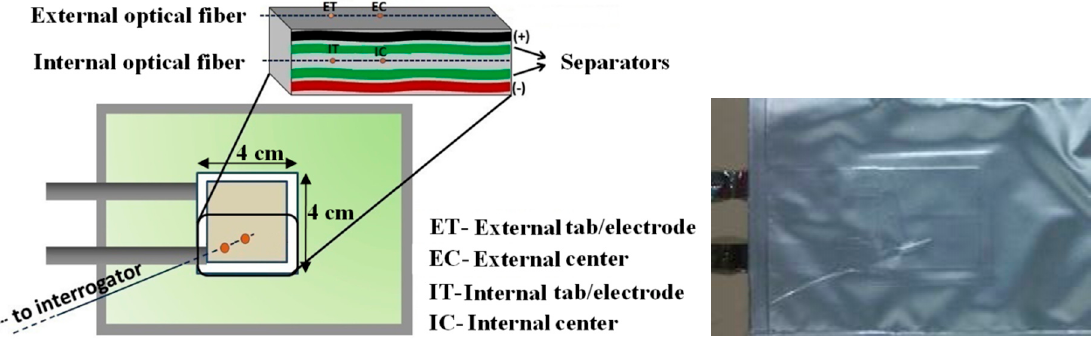
Figure 1. Schematic diagram of internal and external FBG sensors positions. Photograph of a pouch cell with the embedded sensors.